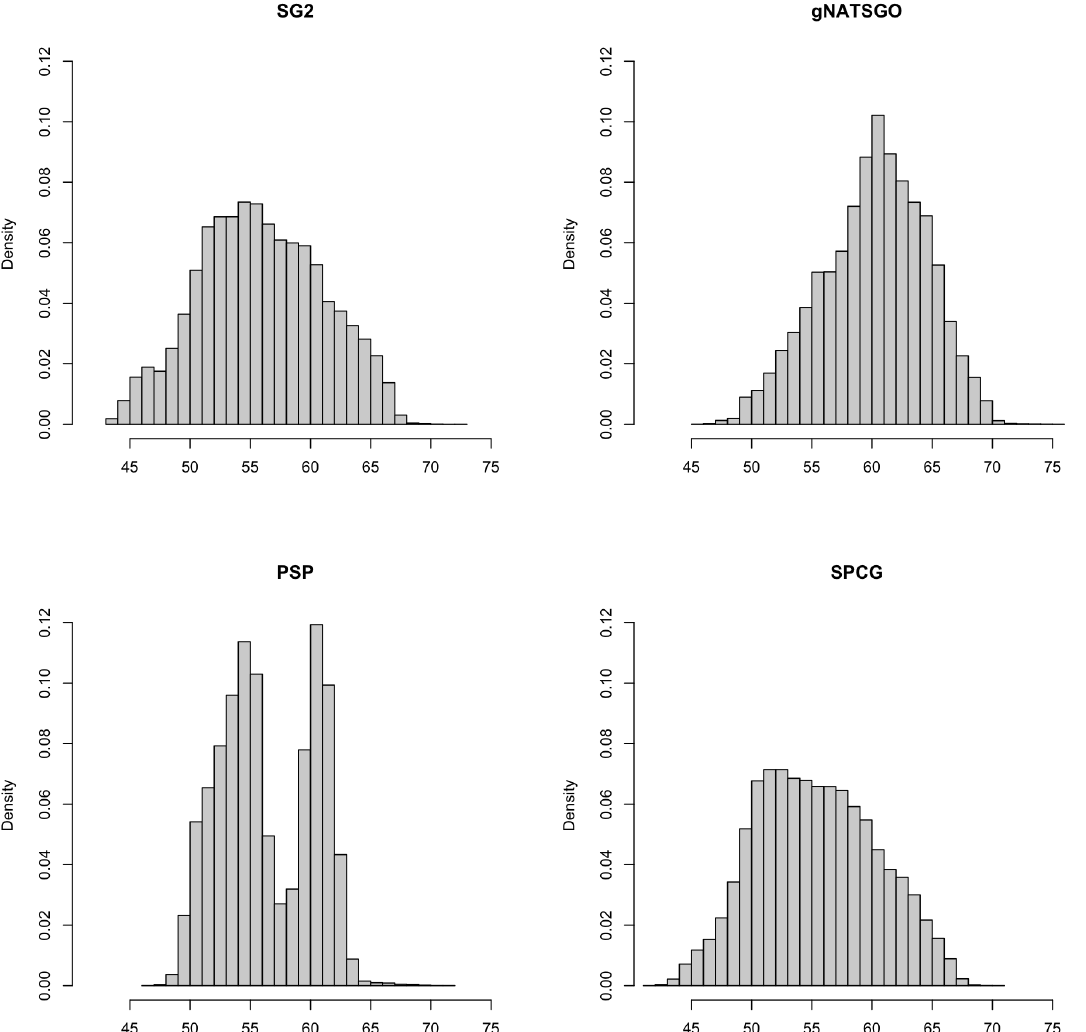
Figure 5. Histograms of pH × 10 at 0–5cm. Note the bimodal distribution of PSP and the flatter distributions of SG2 and SPCG compared to